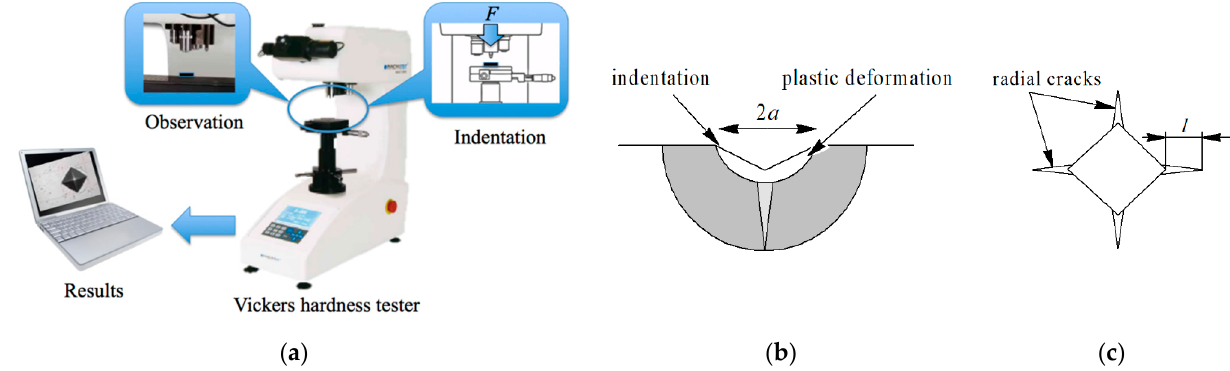
Figure 2. Measurement of hardness and fracture toughness: ( a ) Experimental stand; ( b ) Indentation in the brittle material; ( c ) Radial cracks.